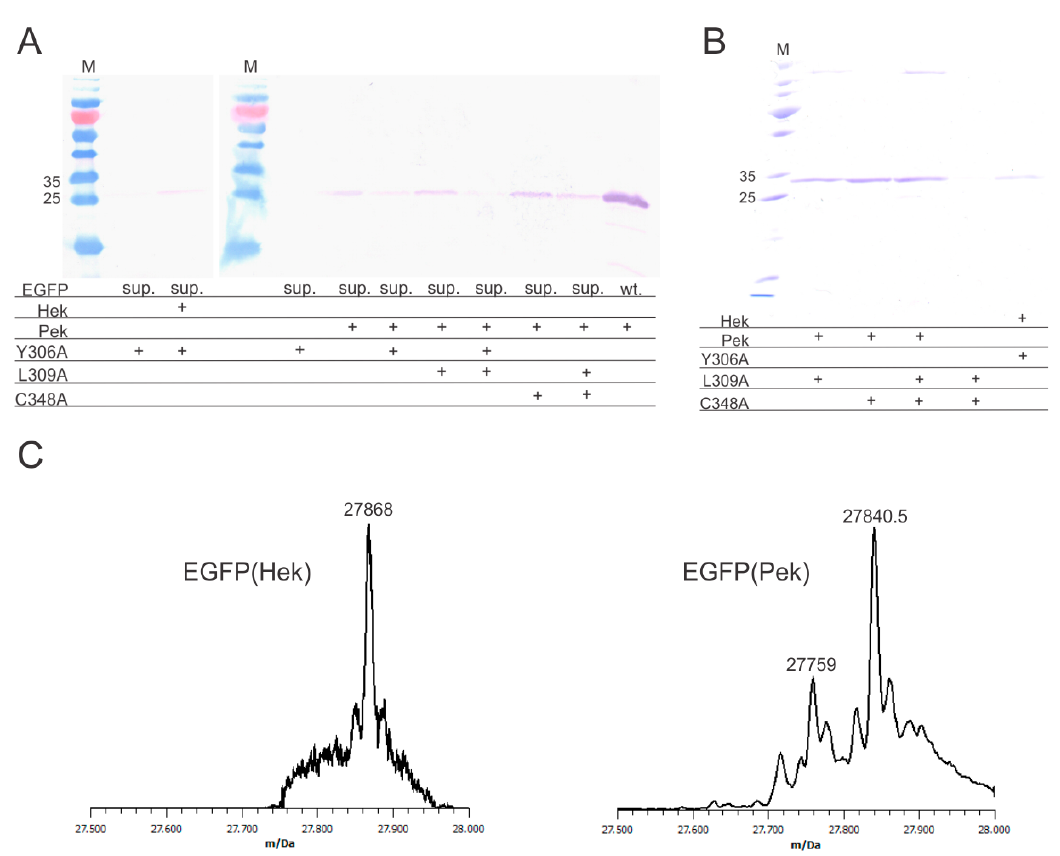
Figure 2. Expression, purification and analysis of the target protein (EGFP)( N ε -heptenoyllysine (Hek)) and EGFP( N ε -pentenoyllysine (Pek)). ( A ) Western blot analysis of cell lysates after expression. The same amount of cell lysate was added to each lane for each individual blot. EGFP(N150amber) (sup.)was used for suppression testing, with wild-type EGFP (wt.) as a control. A quantity of 2 mM of either Hek or Pek were added to the cultures. All pyrrolysyl-tRNA synthetase (PylRS) variants used for suppression had the mutation Y384F with additional mutations indicated; the + indicates the presence of an amino acid or mutation. ( B ) EGFP(150Hek) expressed with PylRS(Y306A/Y384F) and EGFP(150Pek) expressed with different variants after purification. The eluates were adjusted to the same volume, and an identical sample volume was applied to each lane; the + indicates the presence of an amino acid or mutation. ( C ) Deconvoluted ESI-MS spectra of EGFP(150Hek) (calculated mass: 27,868.5 Da; found mass: 27,867 Da) and EGFP(150Pek) (calculated mass: 27,840.5 Da; found mass: 27,840.5 Da). An additional peak at 27,759 Da was found, which may correspond to EGFP(150Gln) (calculated mass 27,759 Da)